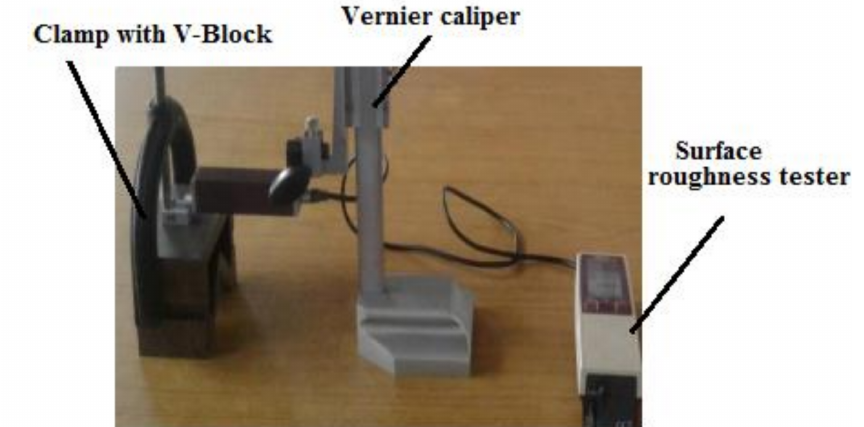
Figure 2. Mitutoyo hardness